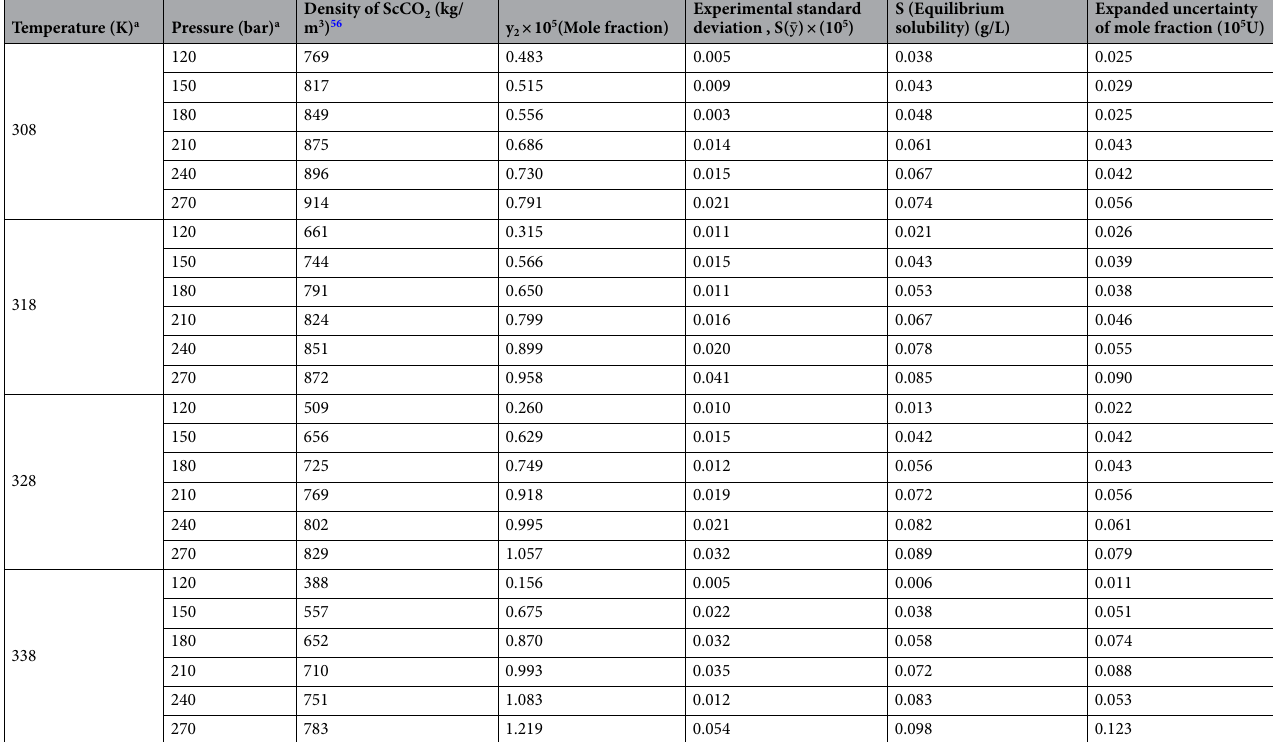
Table 2. Solubility of crystalline Crizotinib in scCO 2 at various temperatures and pressures. The experimentalstandard deviation was obtained by S ( y k )